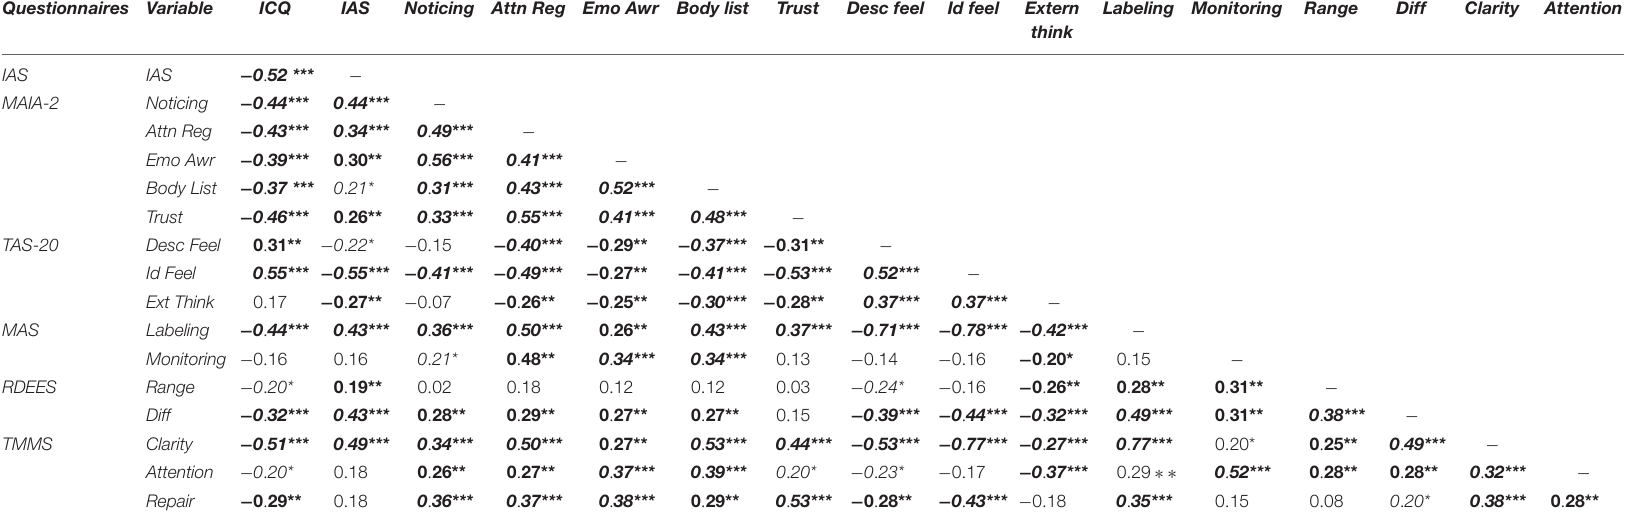
TABLE 1 | Pearson’s correlation matrix for interoception and conceptualization scales. Questionnaires Variable ICQ IAS Noticing Attn Reg Emo Awr Body list Trust Diff Clarity